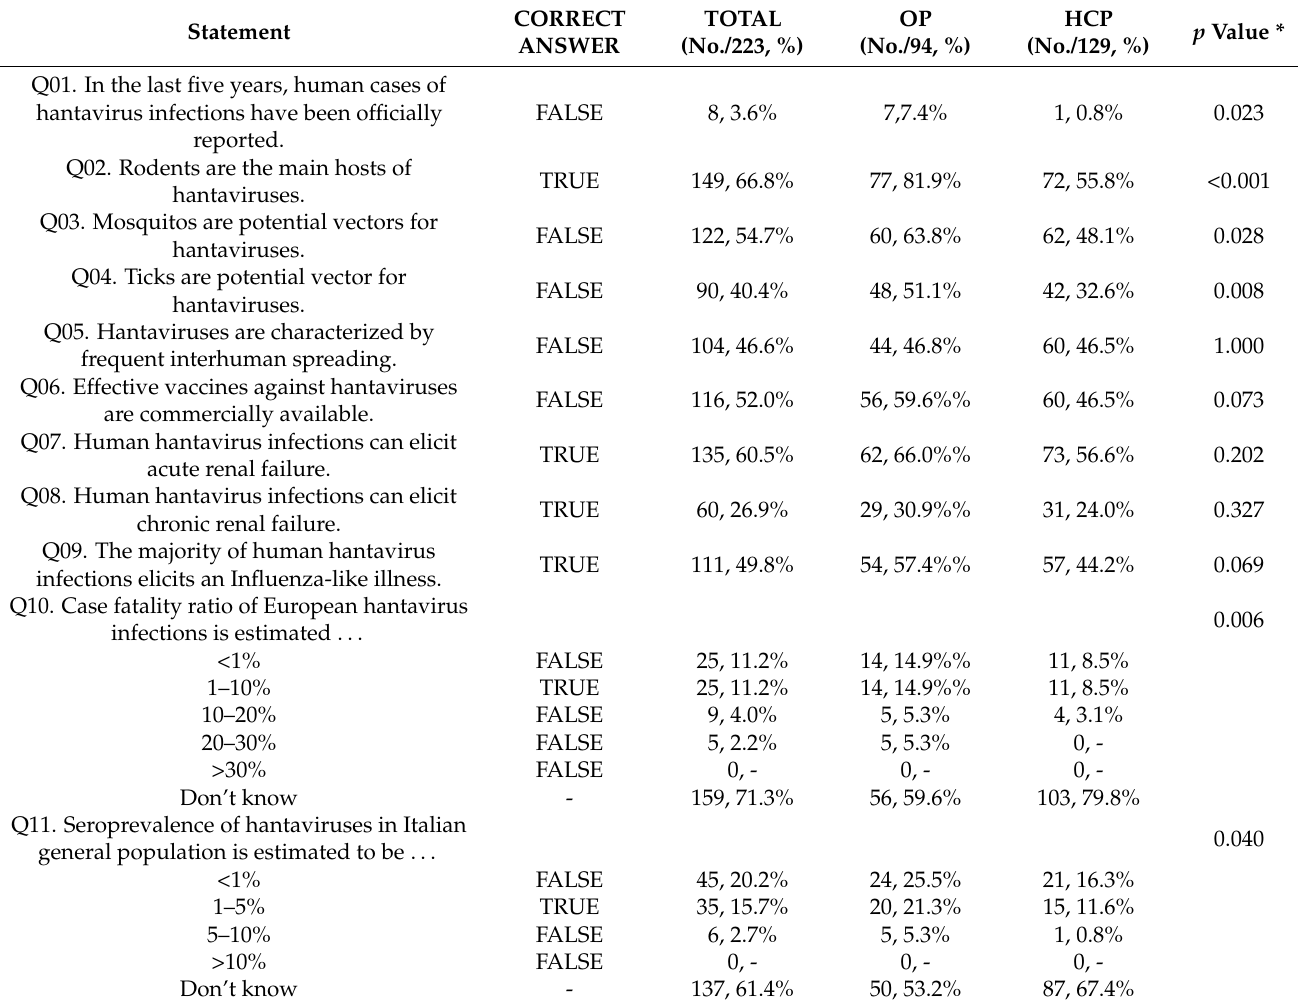
Table 2. Knowledge test: response distribution of presented items proposed to the 223 medical professionals participating in the survey and contributing to the assessment of general knowledge score (GKS) (Cronbach’s alpha = 0.856). Responses in occupational physicians (OP, No. = 94, 42.2% of total sample) were compared to those of all other health care providers (HPC, No. = 129, 57.8% of total sample) by means of chi squared test (with Yates